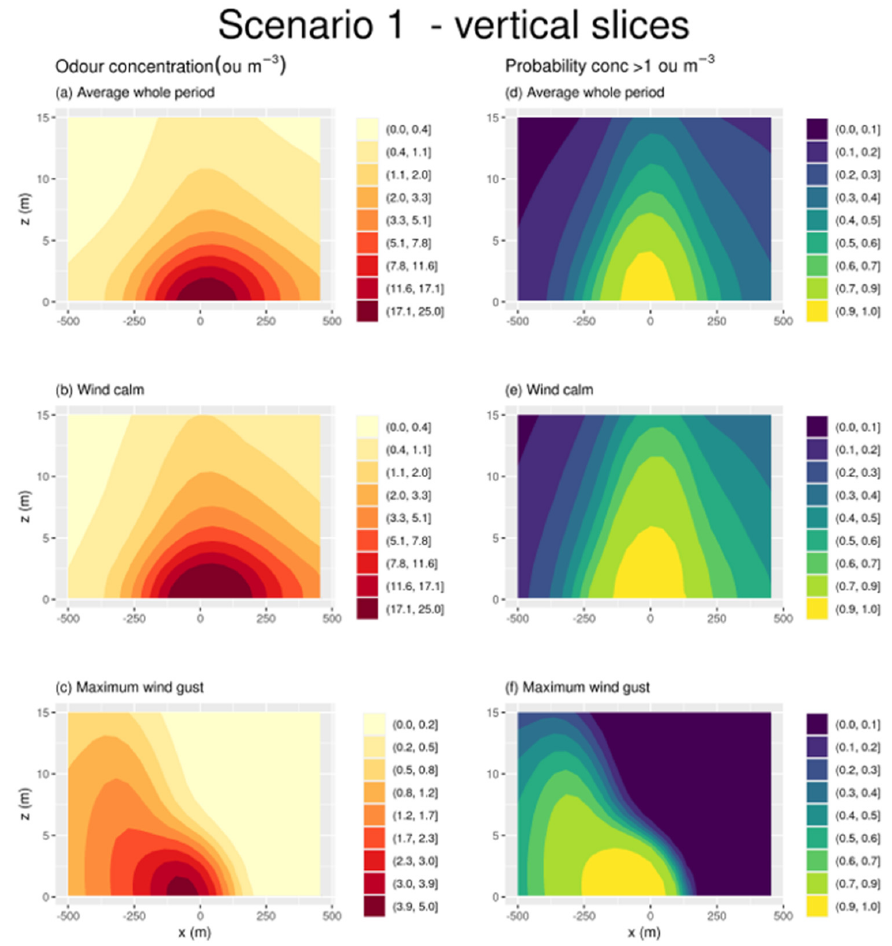
Figure 7. Vertical slices of the odour concentrations (left panel) and exceedance probability of the 1 ou m − 3 threshold (right panel) for an East–West transect placed at the latitude of the source’s center, simulated by SCICHEM for the period 1 October 2020 − 31 October 2020, for scenario 1. Modeled concentrations and probabilities are represented for the whole period ( a , d ), the episodes of calm winds ( b , e ), and the episode of maximum wind gust ( c , f ). Note: the color scale for the concentrations is different in the maximum wind gust event from the other two cases (average conditions, wind calm conditions).